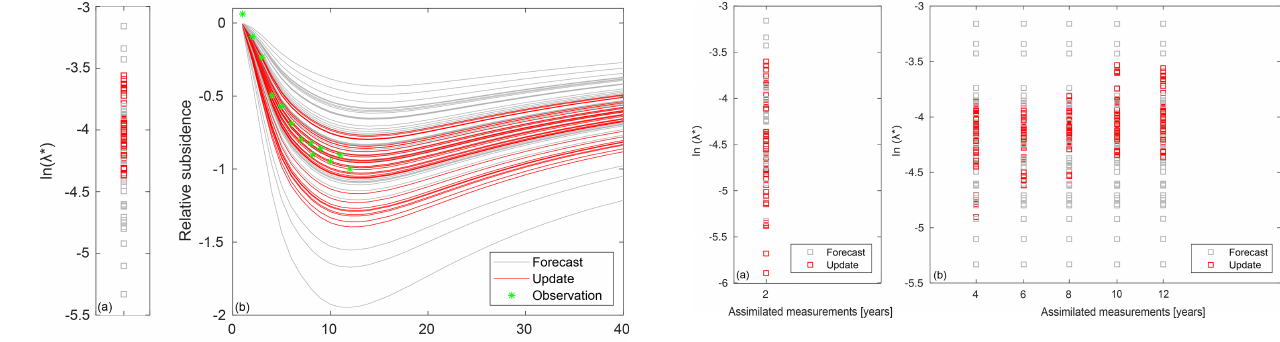
Figure 4. Outcomes of ES used in a predictive sense: parameter ensembles for increasing years of assimilated